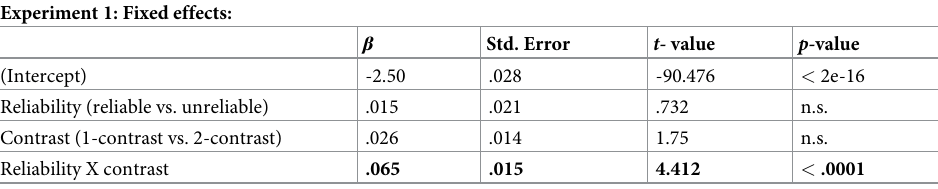
Table 1. Summary of final linear mixed model of fixation proportions in Experiment